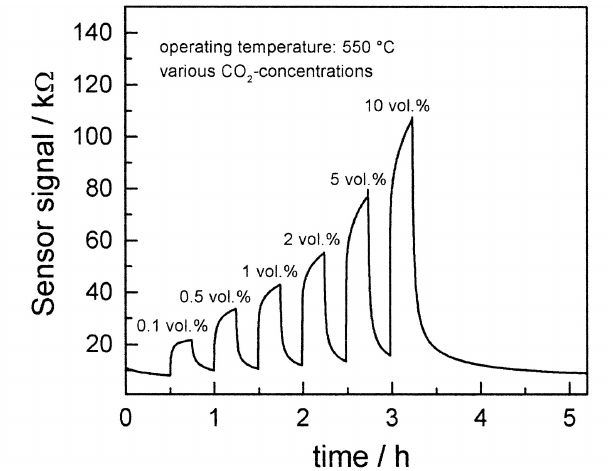
Figure 14. The effect of varying CO material (note the baseline increase over time). Figure adapted with permission from